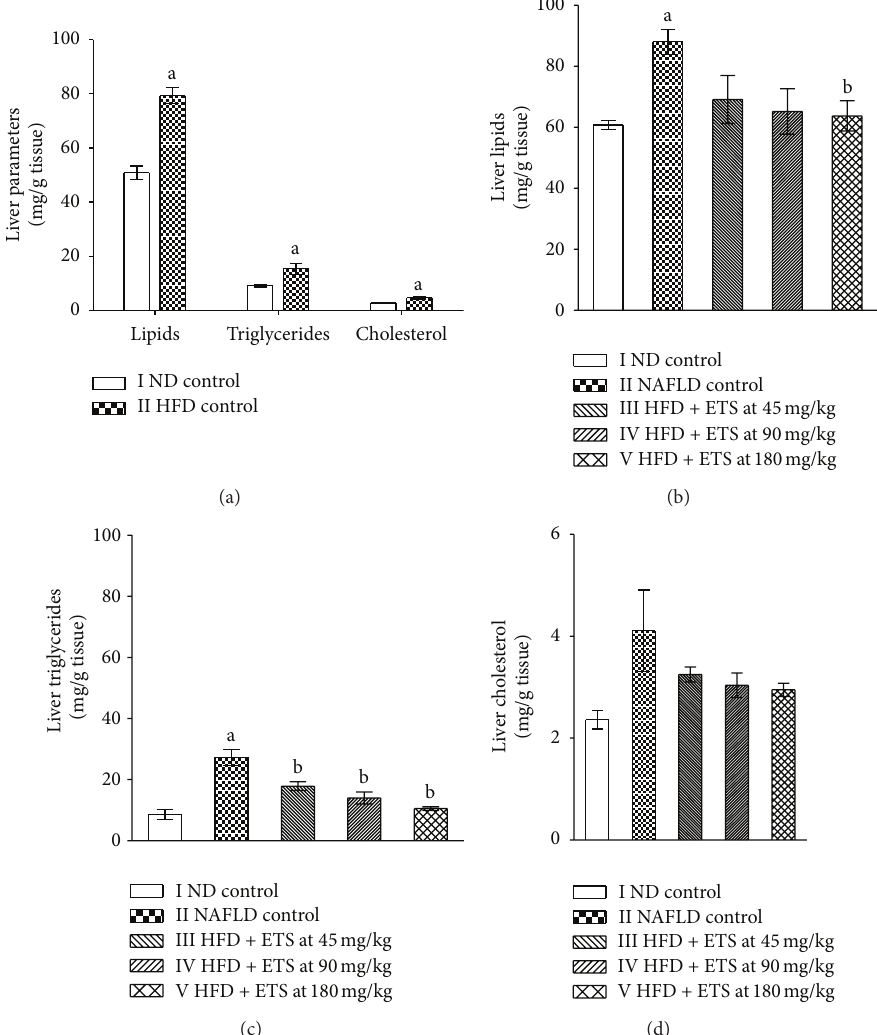
Figure 2: Effect of high fat diet and ETS treatment on liver lipid parameters in rats (a) after induction (b) after ETS treatment. Rats were orally treated by high fat diet with or without ETS daily for 6 weeks, after induction of NAFLD by HFD feeding for 6 weeks. Values are expressed as Mean ± SEM; 𝑛 = 6 ; a 𝑃 ≤ 0.05 , HFD/NAFLD control vs ND control, b 𝑃 ≤ 0.05 , treated groups vs NAFLD control ETS: extract of Tamarindus indica seed coat; ND: normal diet; HFD: high fat diet; NAFLD: nonalcoholic fatty liver